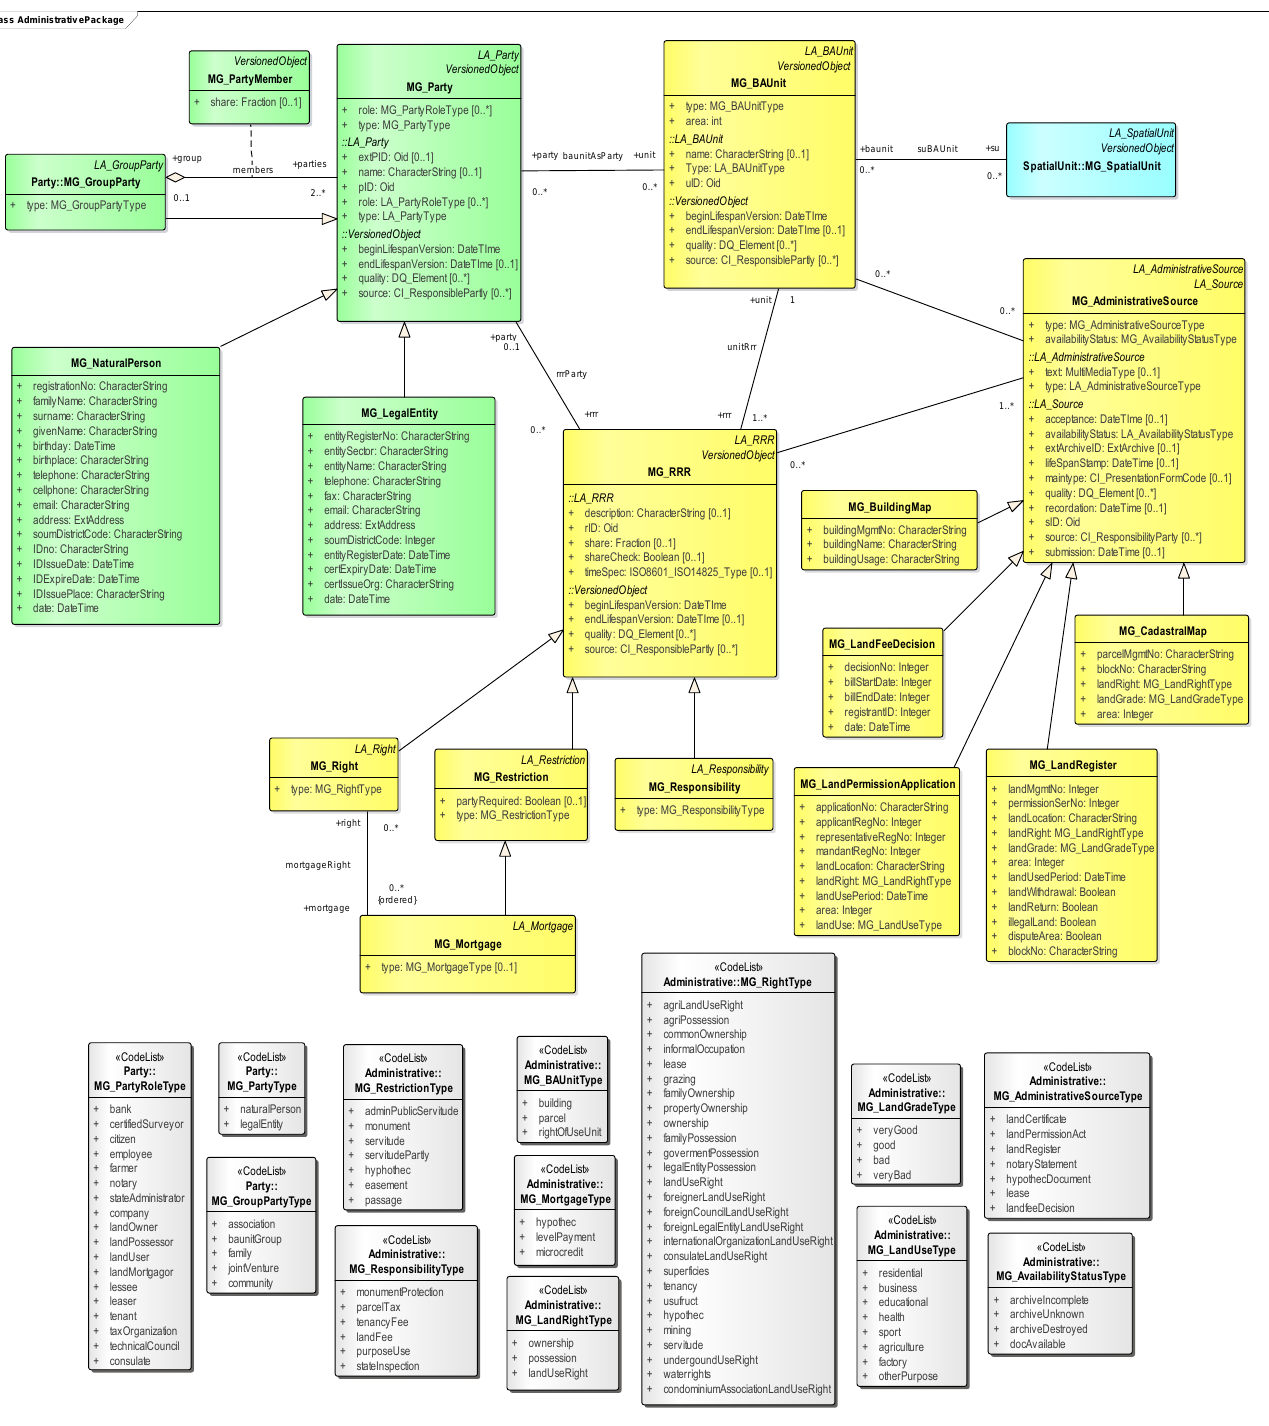
Figure 6. Administrative (Party and Administrative package) part of the Mongolian LADM Pro- file.